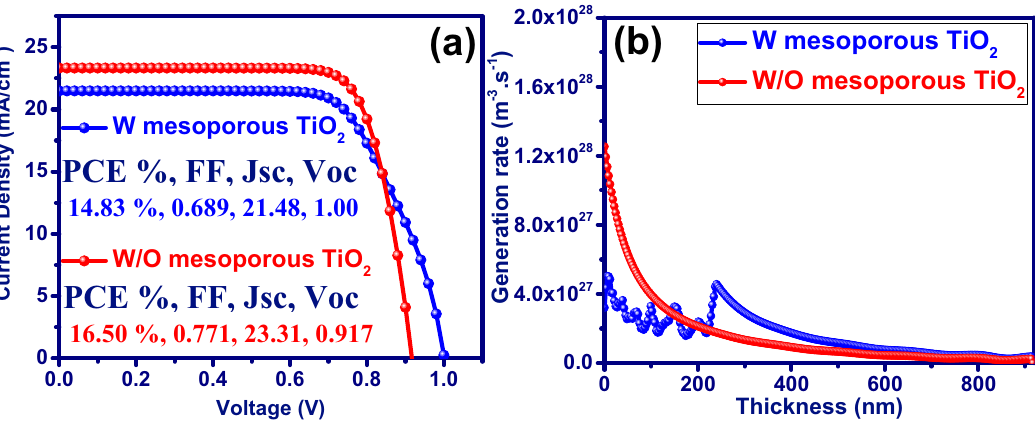
Figure 2. ( a ) J–V characteristics of the device and ( b ) Spatial profile of photo-generated charges in CH 3 NH 3 PbI 3 photoactive layer with (W) and without (W/O) incorporation of mesoporous TiO 2